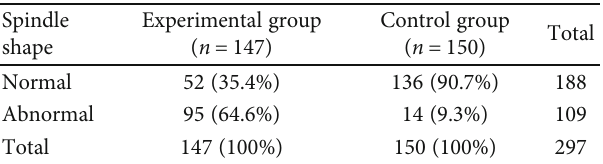
Table 3: Comparison of the spindle shape between the experimental group and the control group.